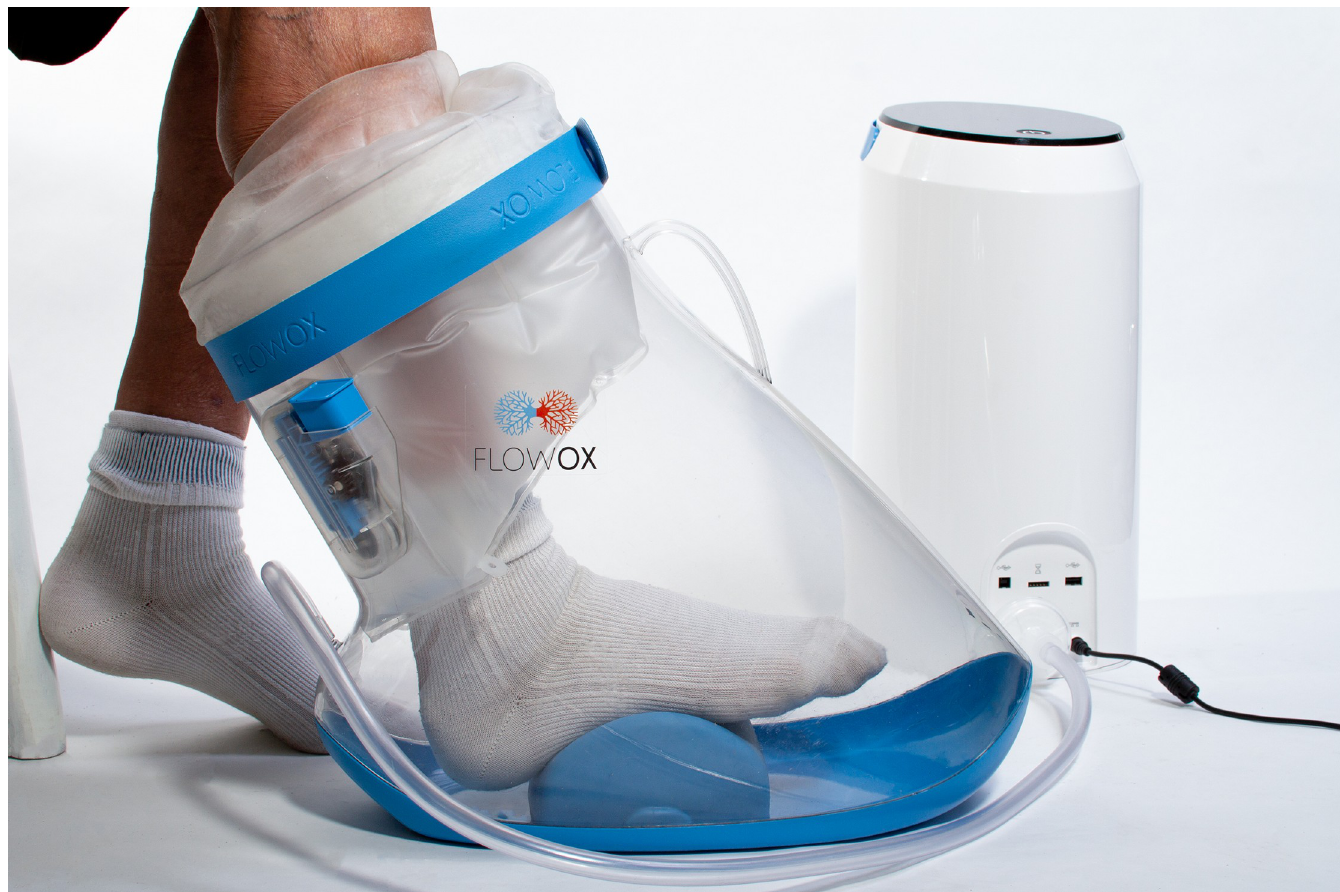
Fig 1. FlowOx ™ devices and